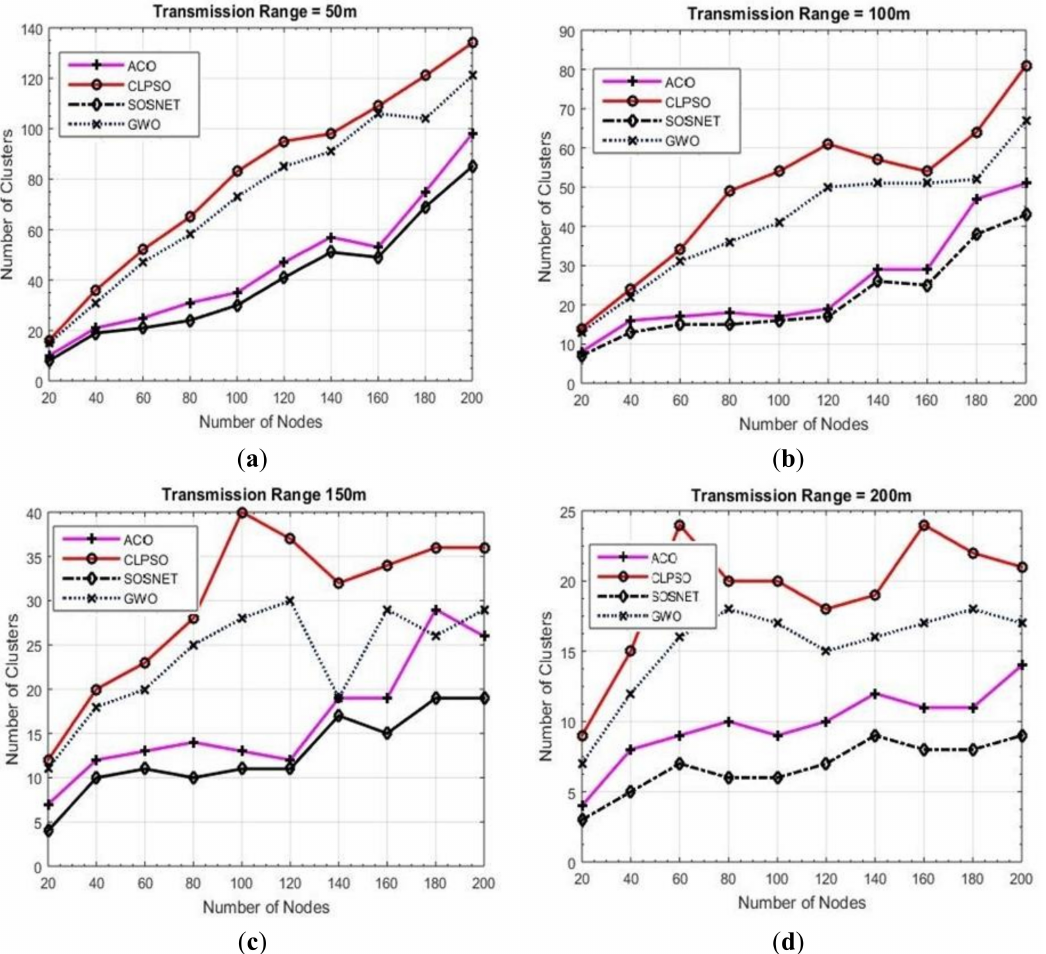
Figure 8. Grid size 1500 m × 1500 m, transmission ranges 50 to